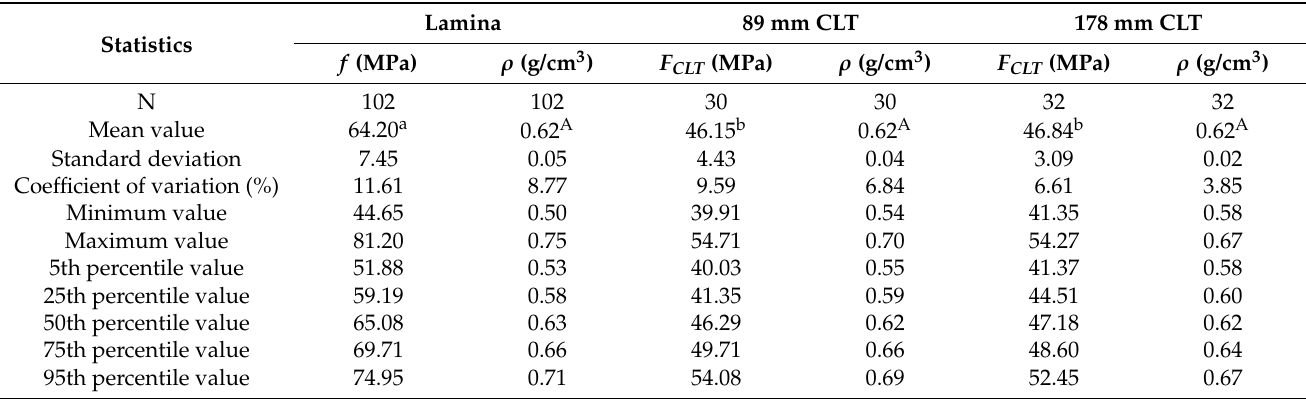
Table 2. The statistical tests for the density and compressive strength of the lamina and CLT samples with two different